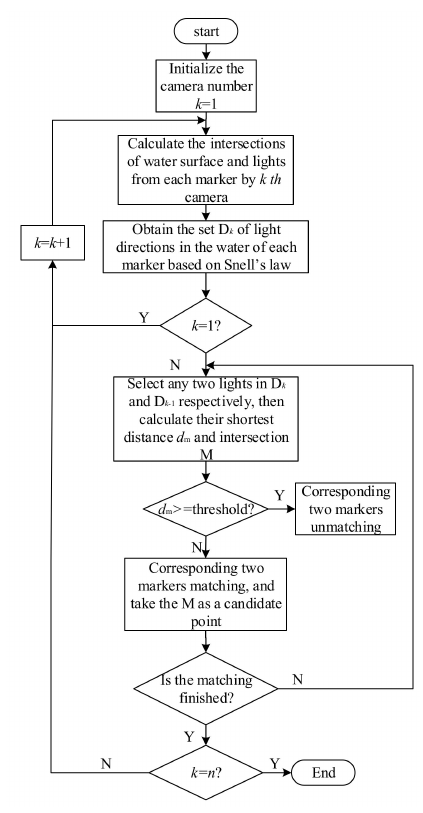
Figure 3. Markers matching flow